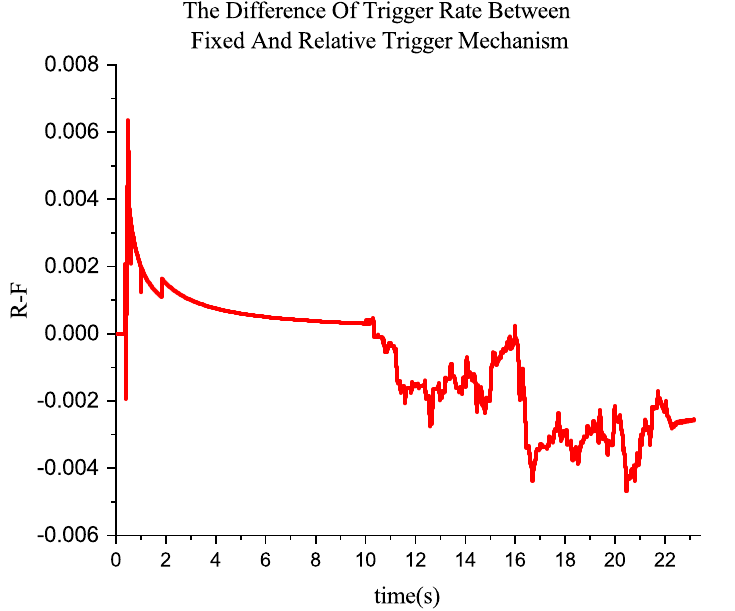
Figure 17. The difference in trigger rate of the two event-triggering mechanisms.